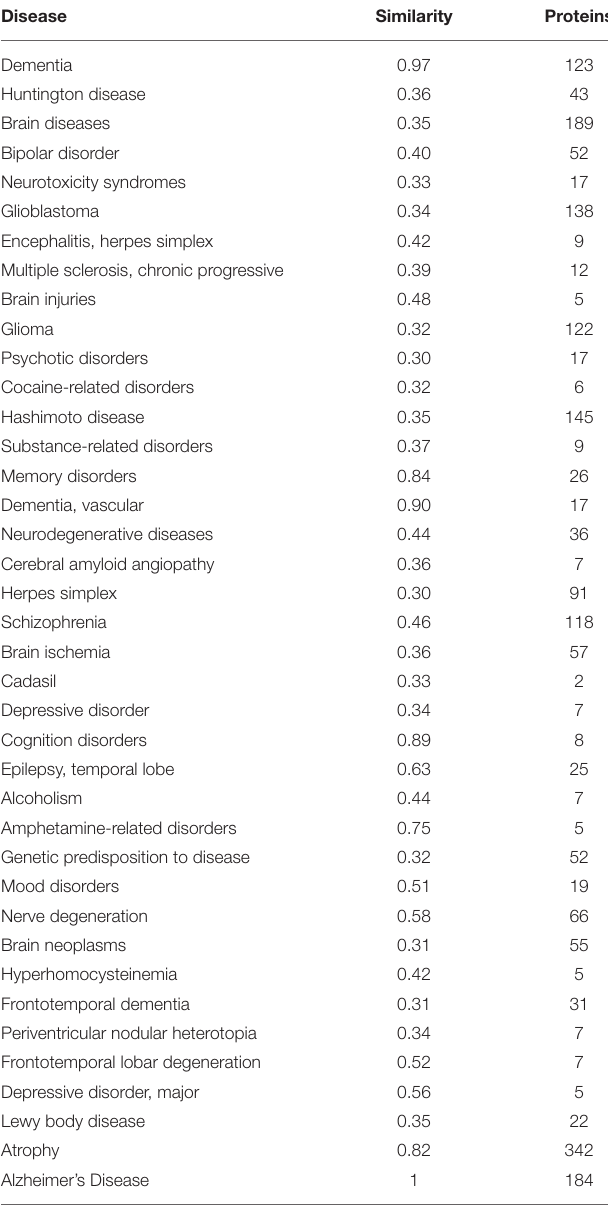
TABLE 1 | Statistics of AD-related diseases. Disease